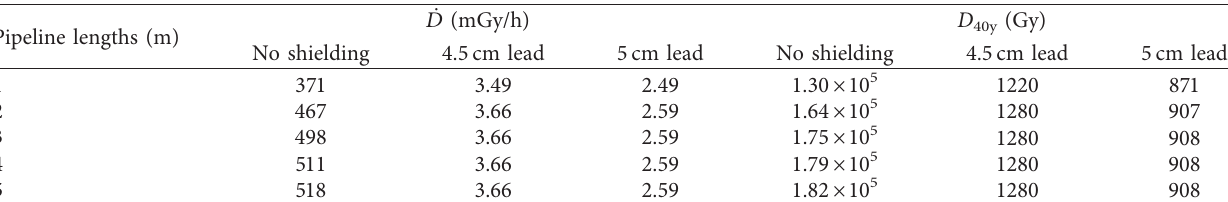
Table 3: _ D and D � 30cm for 1–5m pipelines for the average burn-up fuel source 40y at Dpi